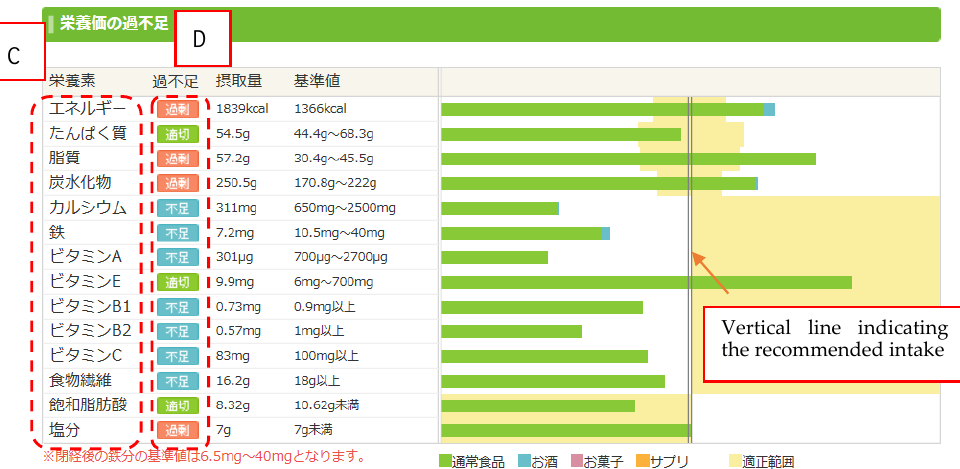
Figure 3. Graph of energy and nutrient intakes generated by Asken on the basis of data input by the user. Translation of text in area C (top to bottom): energy, protein, lipids, carbohydrates, calcium, iron, vitamin A, vitamin E, vitamin B1, vitamin B2, vitamin C, dietary fiber, saturated fatty acids (not included in the present study), and salt. In area D, red boxes indicate excessive intakes, green boxes indicate appropriate intakes, and blue boxes indicate deficiencies. The vertical line shows the recommended intake.